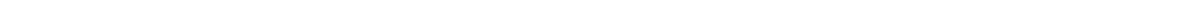
Fig. 1 An “ endothelialized ” micro fl uidic system coupled with a microengineered pneumatic valve that induces a vascular “ injury ” functions as a comprehensive in vitro mechanical injury bleeding model. a Our micro fl uidic-based bleeding device is constructed from b three polydimethylsiloxane layers: a vascular layer comprised of a vascular channel and outlet channel, a valve layer, and a valve actuator layer. c First, endothelial cells are cultured to con fl uence in the vascular channel while the pneumatic valve is in the closed position (left). When the valve layer is pulled down by negative pressure in valve actuator channel (pull) and mechanical fl uidic pressure (push) is applied through outlet channel, the vascular channel is disrupted and endothelial injury is mechanically induced (middle). Blood is perfused while the valve is maintained in the open position and fl ows through the vascular channel (horizontal) as well as the newly created “ bleeding ” wound channel, which leads to the outlet channel (right). d A computational fl uid dynamic COMSOL simulation shows initial wall shear stresses when the mechanical injury is introduced. e Our in vitro microcvasculature mechanical injury model enables real-time visualization of the entire hemostatic process. Con fl uent endothelial cells (stained via a plasma membrane stain — blue) are disrupted when the valve opens and “ bleeding ” occurs through the injury site. Immediately, platelets (stained via CD41 — red) begin to adhere at the injury site (red arrow) followed by fi brinogen/ fi brin accumulation ( fl uorescent tagged fi brinogen, green) until fi nally hemostasis is achieved. All scale bars = 50 µ